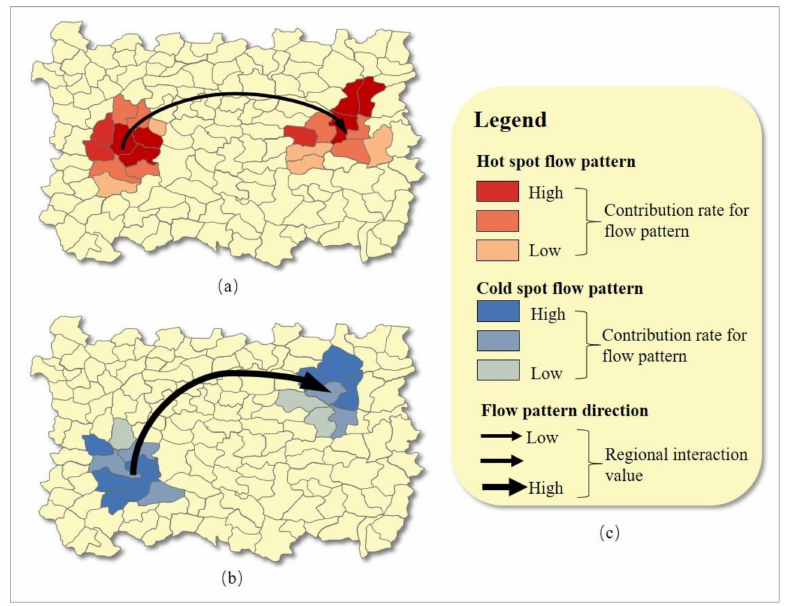
Figure 6. Two examples and instrumental definition of single RG-Flow-Pattern visualization. ( a ) A regional interaction hotspot flow pattern with low interaction value; and ( b ) a regional interaction cold-spot flow pattern with high interaction value; and ( c ) legend of